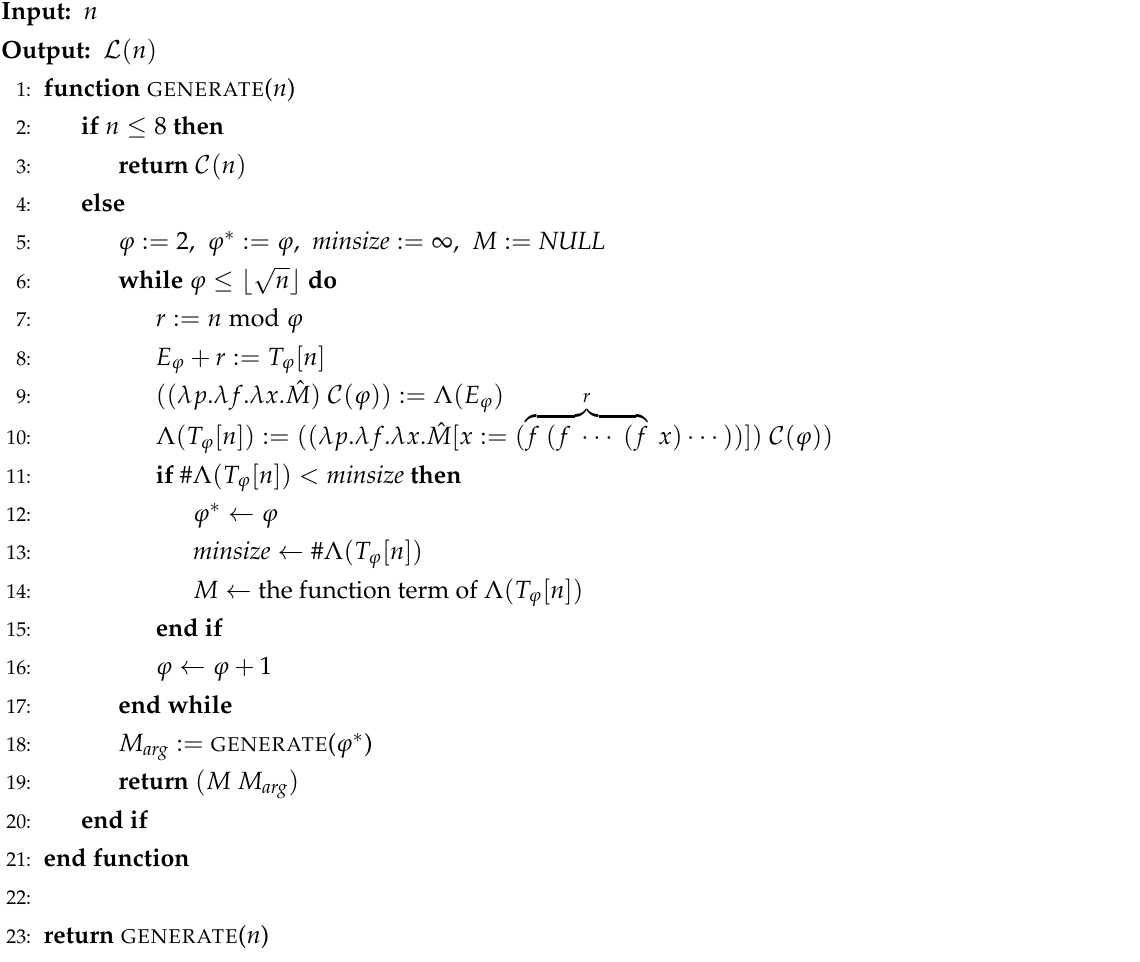
Algorithm 2 Generation of L ( n ) for a given natural number n